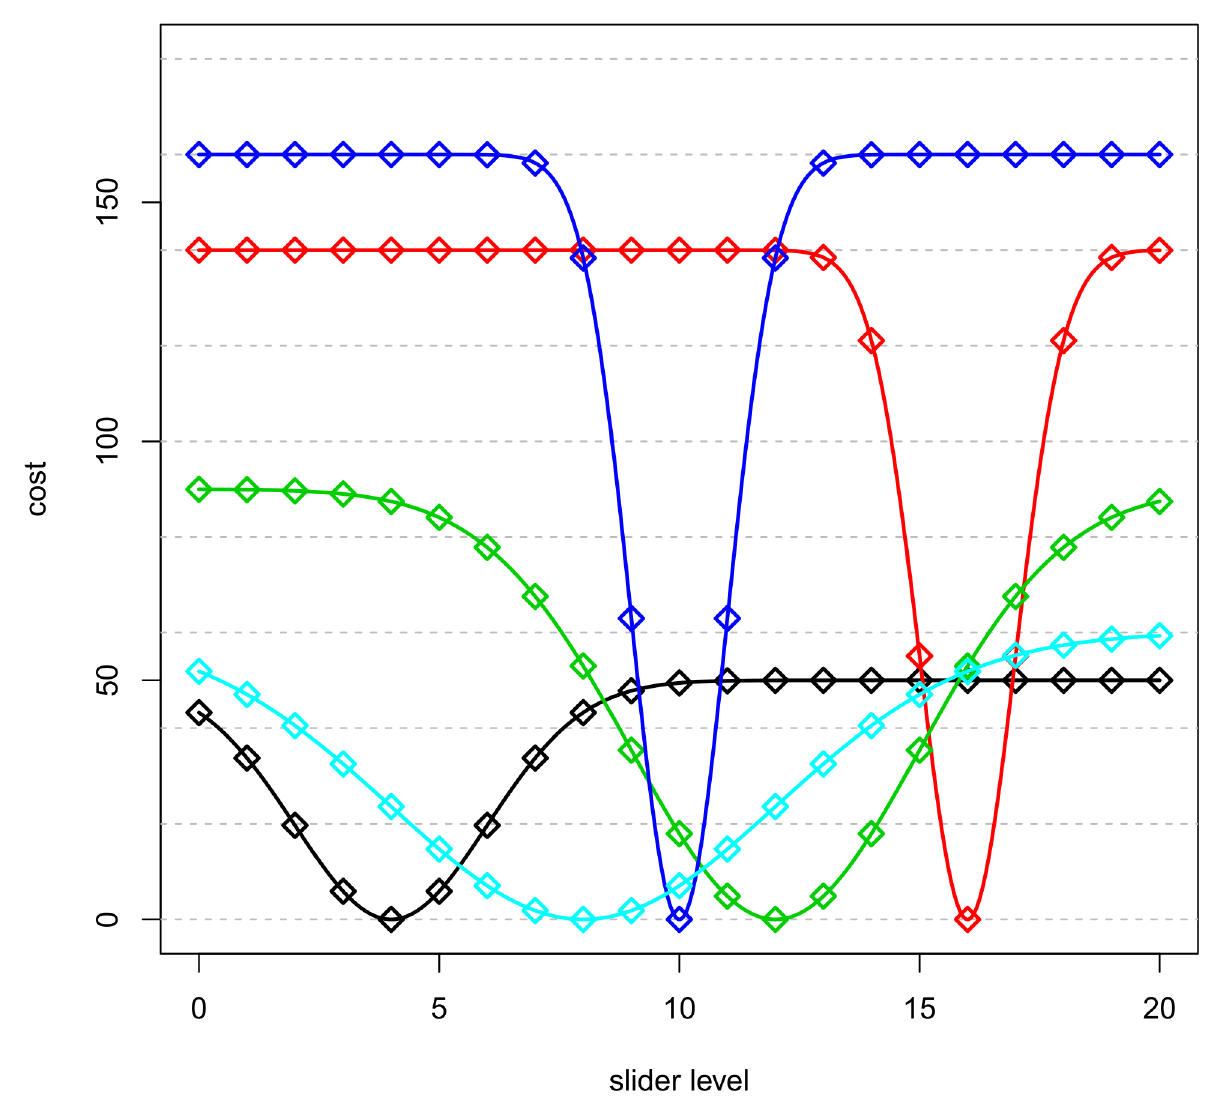
Fig 2. Sliders’ cost